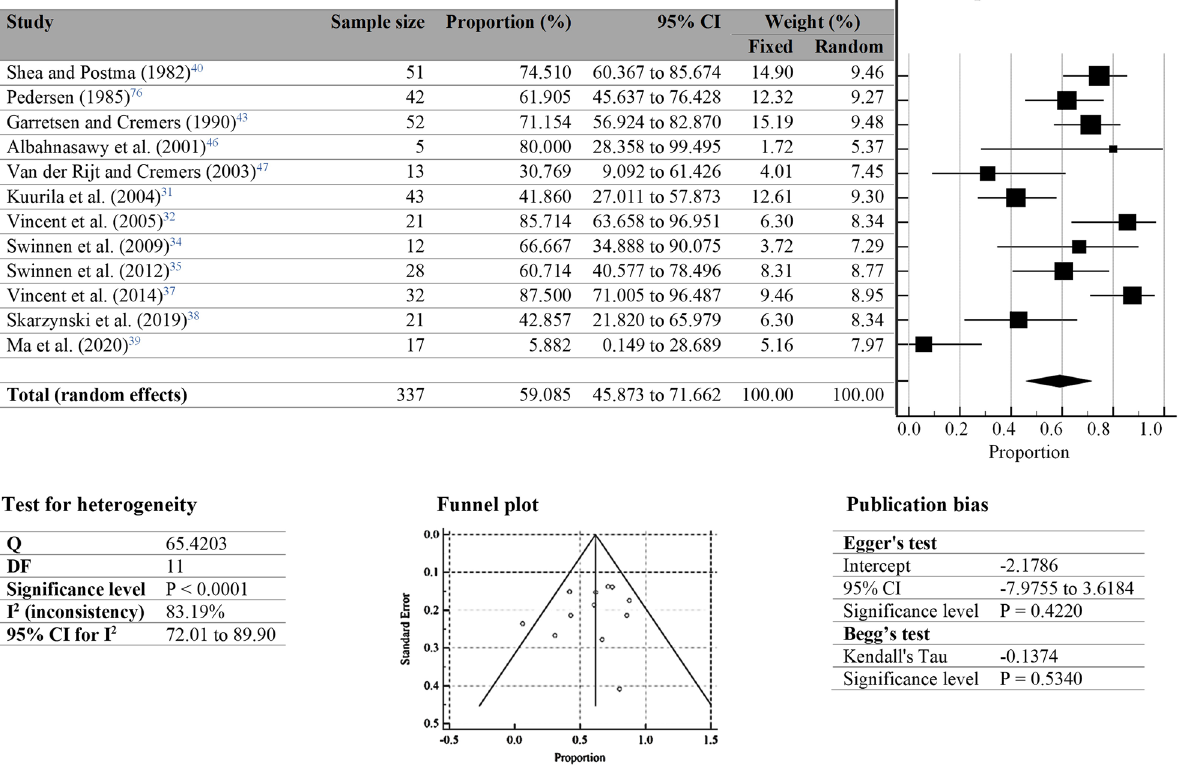
Figure 2. Efficacy of stapes surgery in the osteogenesis imperfecta population in the short term. Studies included for meta-analysis are shown in the table together with the overall result with its corresponding sample size, effect size represented as a proportion (proportion of ears with a postoperative Air Bone Gap (ABG) ≤ 10 dB), 95% confidence interval (CI), and weight for random effect model. The forest plot graphically represents the results. There, each study is represented with a box. The size of each box represents the weight of each study whereas the lines determine their 95% CI. The overall result is shown by a diamond in which the middle indicates the estimate, and the sides represent its 95% CI. Our meta-analysis shows an overall result of 59.01% (95% CI 45.87 to 71.66). The test for heterogeneity table shows Cochrane’s Q test, degrees of freedom 2 (DF), significance level, inconsistency value ( I ), and its corresponding 95% CI. Significative heterogeneity was 2 found in our results (P < 0.0001) and I of 83.19% (95% CI 72.01 to 89.9). The funnel plot was used to detect publication bias of meta-analysis by plotting the standard error over the proportion (effect size). The diagonal lines represent the 95% CI around the summary effect size. Studies are represented with dots. Publication bias were also assessed with Egger’s and Begg’s test, represented with an intercept, a 95% CI and a significance level; and Kendall’s Tau and significance level, respectively. Results indicate low to no risk of bias across studies (Egger’s test, P = 0.42; and Begg’s test, P =